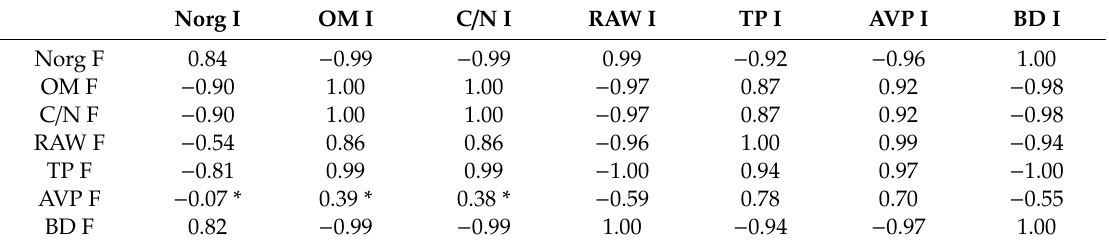
Table 3. Correlations between the initial (I) and final (F) properties of substrates. Norg I OM I C / N I RAW I TP I AVP I BD